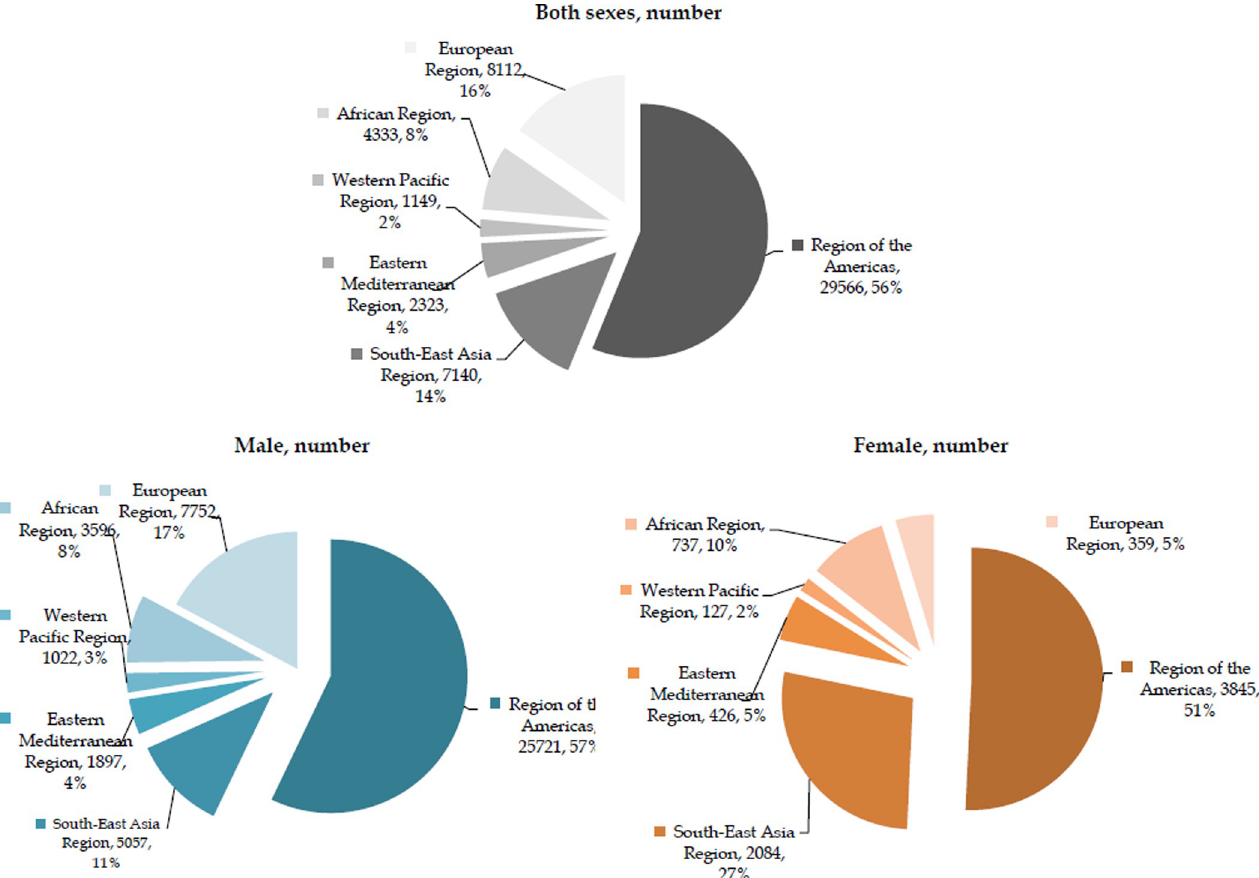
Fig 2. Number of suicides by firearm (global and by WHO regions), by sexes, 2019. Source: GBD estimates [20]. (2.69 per 100,000), followed by the United States of America (1.66 per 100,000) and Uruguay (1.30 per 100,000), while the lowest mortality rate (equally 0.01 per 100,000 people) was observed in Republic of Korea, Singapore, Japan, China (Fig 5).